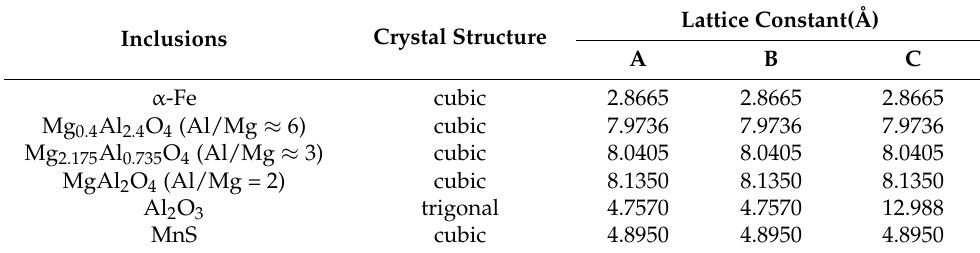
Table 8. Crystal structure of the related inclusions (ICSD).